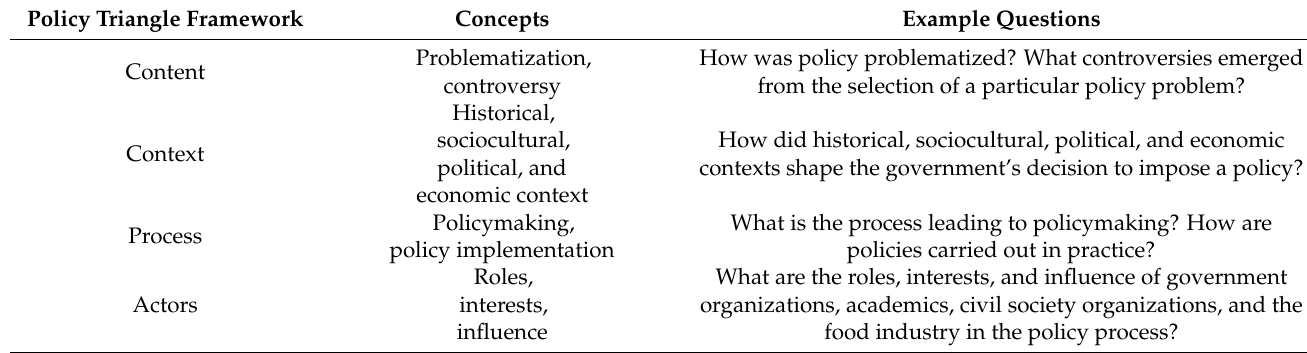
Table 1. Concepts explored in interviews.